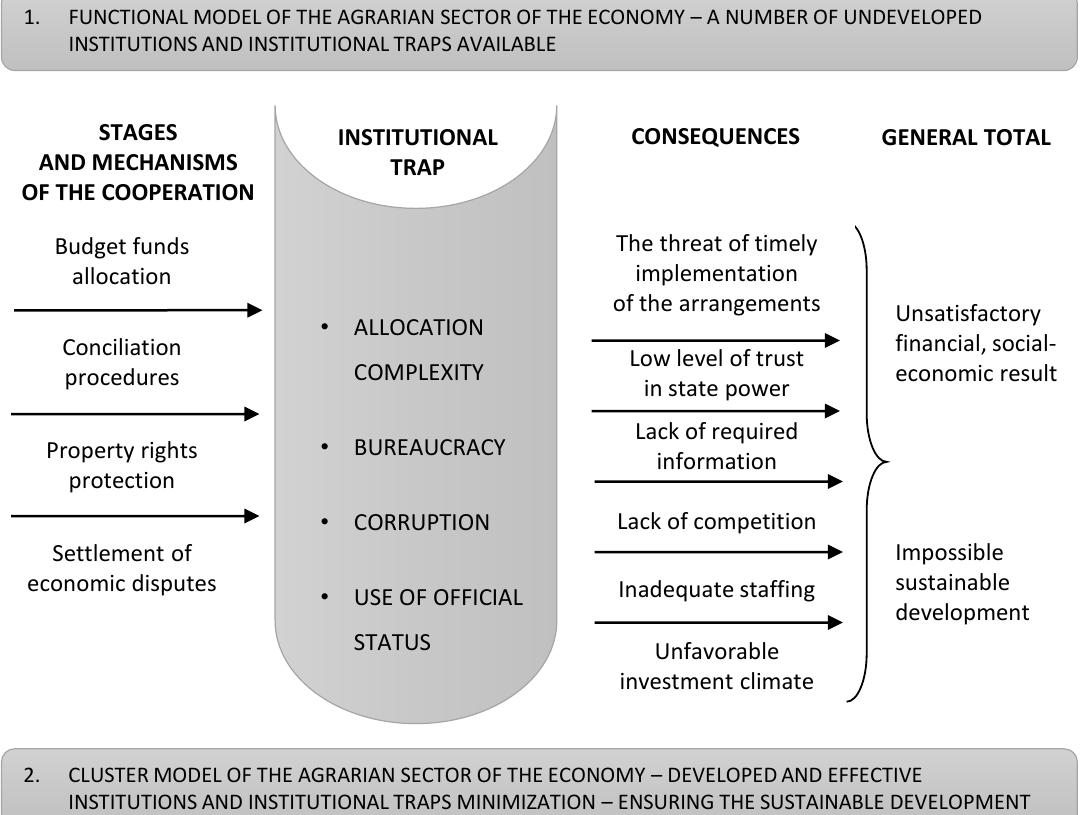
Figure 3. Functional model of the agrarian